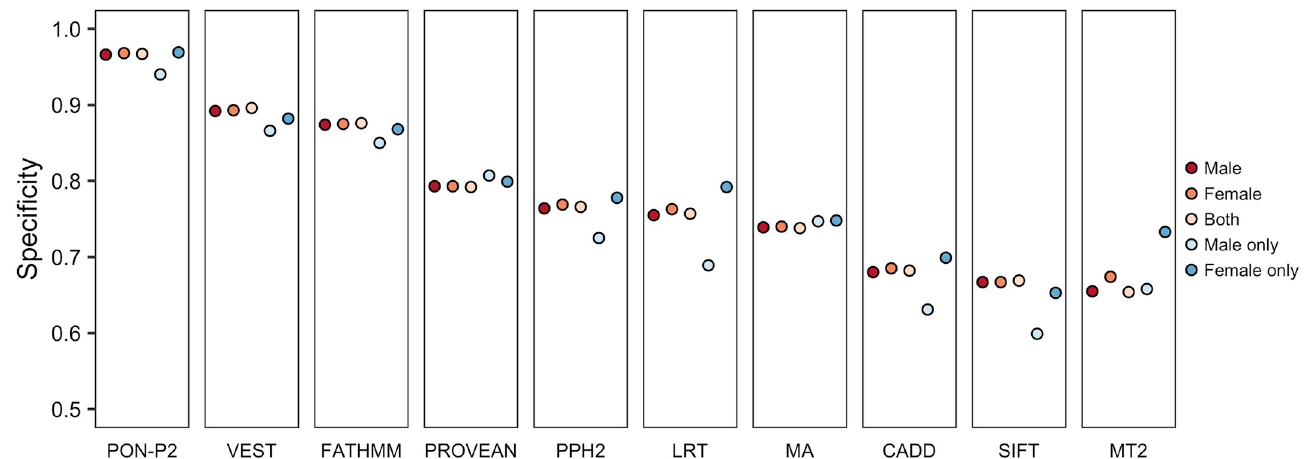
Fig 4. Performance of variant tolerance predictors for variants in males and females. Results are shown for all variants for males and females, both, as well as for unique variants in male (AF � 1% in male but < 1% in female) and female (AF � 1% in female but < 1% in male) populations.